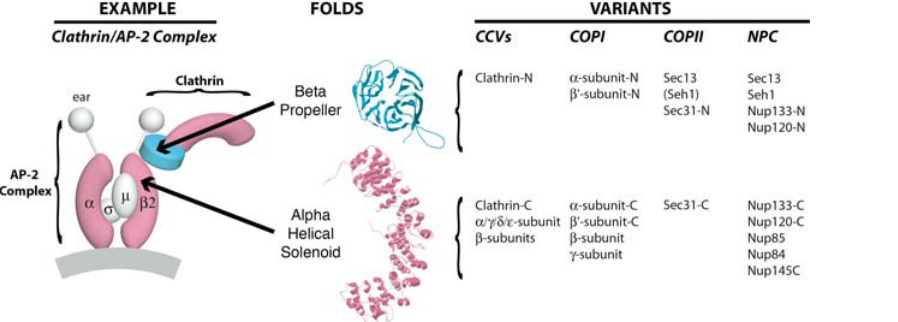
-N and -C indicate amino-terminal and carboxyl-terminal domains, respectively. The classification of these domains is based on X-ray crystallography data (clathrin, a -adaptin, b 2-adaptin [PDB codes 1gw5, 1bpo, 1b89 (ter Haar et al. 1998; Collins et al. 2002)]), by the detailed homology modeling presented here (yNup84 complex proteins; ySec13 also in Saxena et al. [1996]), or by sequence homology or unpublished secondary structure prediction and preliminary analyses (COPI I (sec31) complex proteins [Schledzewski et al. 1999], Sec31). DOI: 10.1371/journal.pbio.0020380.g004